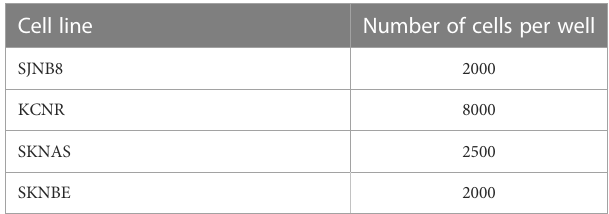
TABLE 1 Seeding densities in 384-well plates used for high-throughput drug